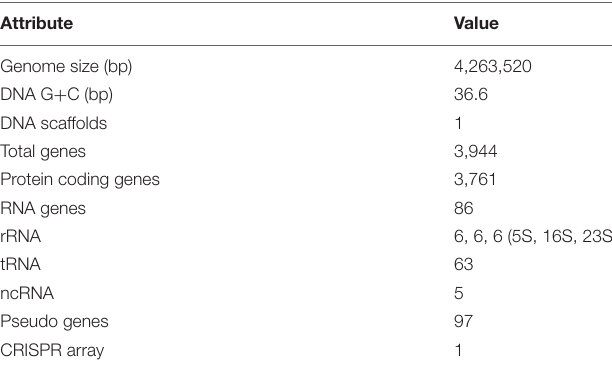
TABLE 4 | Statistics of V. dokdonensis strain 21D genome.